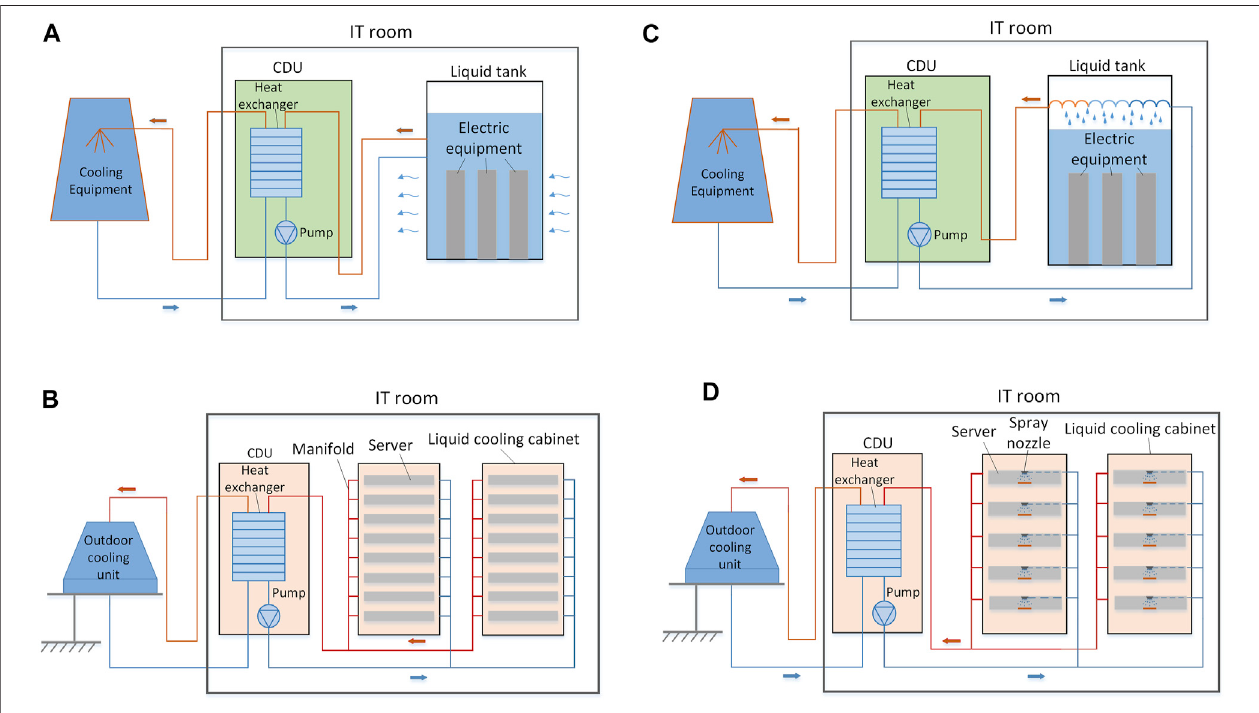
FIGURE 1 | Schematic diagram of liquid cooling technology for DCs: (A) single-phase immersion liquid cooling, (B) two-phase immersion liquid cooling, (C) cold plate liquid cooling, and (D) spray liquid cooling.